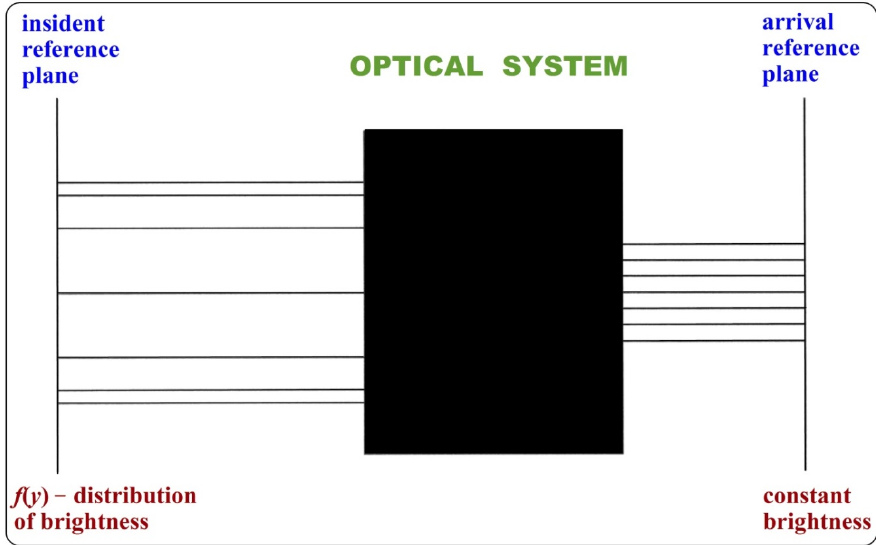
Figure 3. Propagation of a wavefield through the afocal optical system.